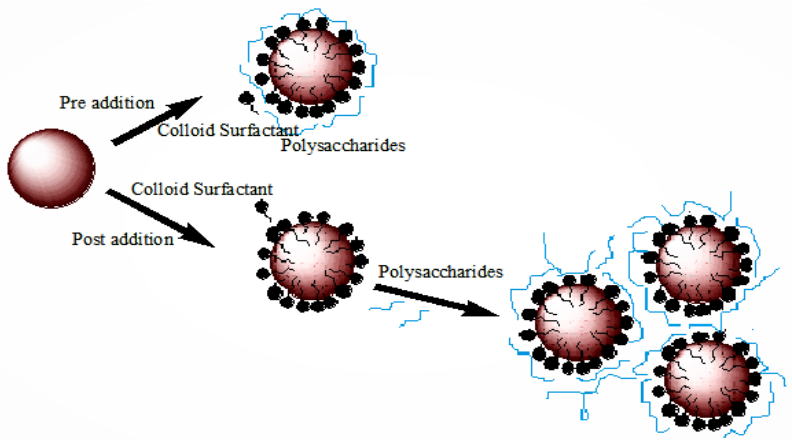
Table 2. Differences between emulsion and nanoemulsion.